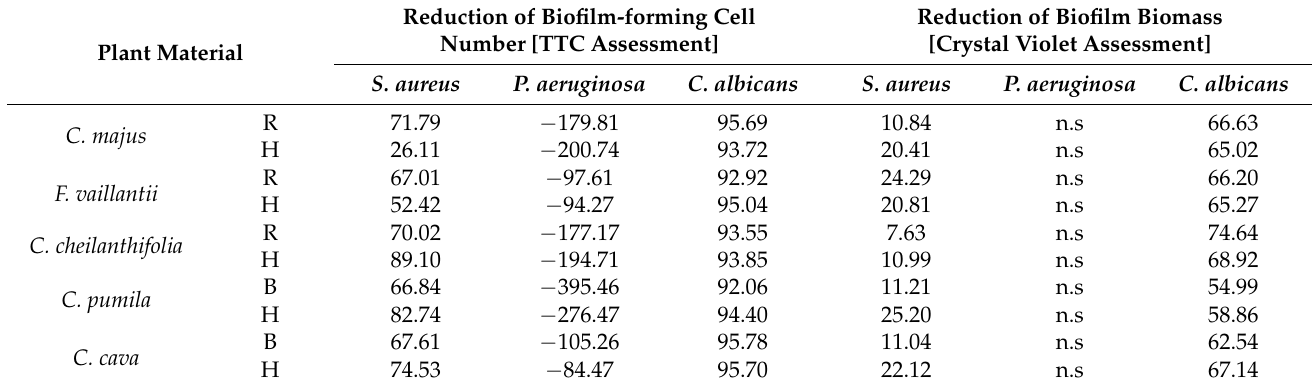
Table 3. Percentage reduction (%) of biofilm cells treated with extracts in the concentration of 50% ( v / v ) using the TTC and crystal violet (CV) method. The untreated control setting was established as 100% of microbial bacterial activity or biofilm biomass (method using TTC and CV, respectively). Please note that in the case of P.aeruginosa , the exposure on extracts led to an increase of metabolic activity measured by the TTC method; in the case of the biofilm assessment using the crystal violet assay, the results are not shown (n.s.) due to the low usability of this particular plate-based technique for pseudomonal